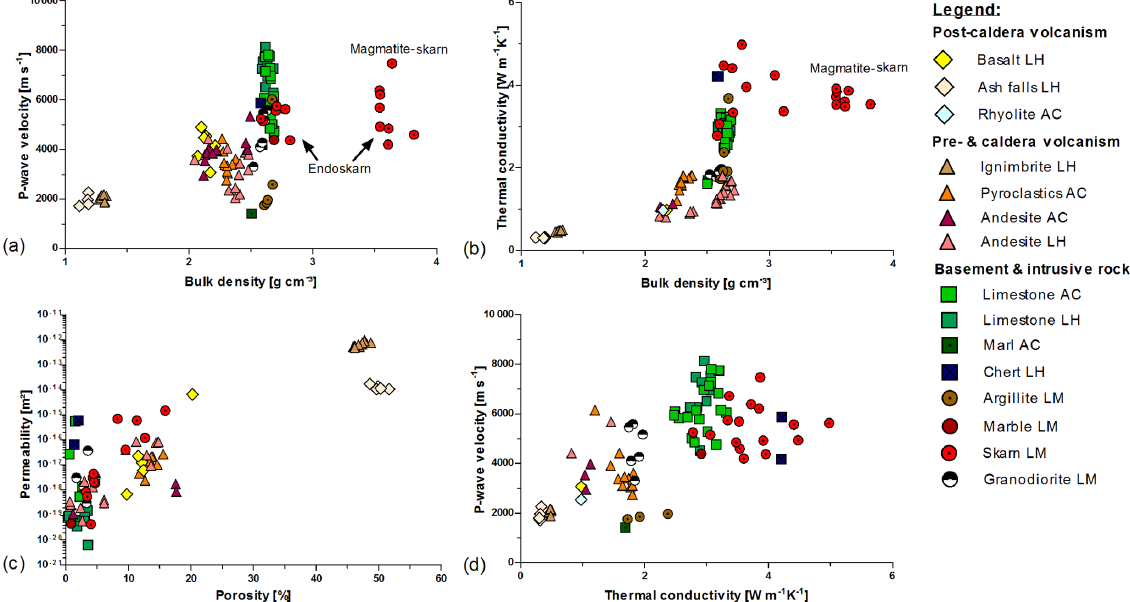
Figure 3. Petrophysical properties measured at dry conditions. The Pre-caldera and Caldera group were merged for simplification. For the number of analysed samples please see Table